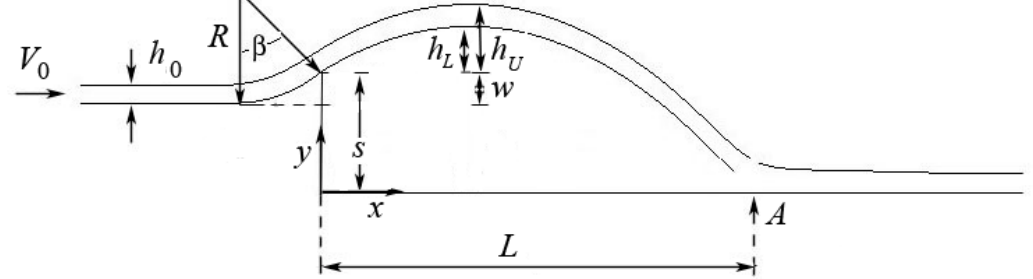
Figure 1. Definition sketch and geometric parameters of a ski jump flow.